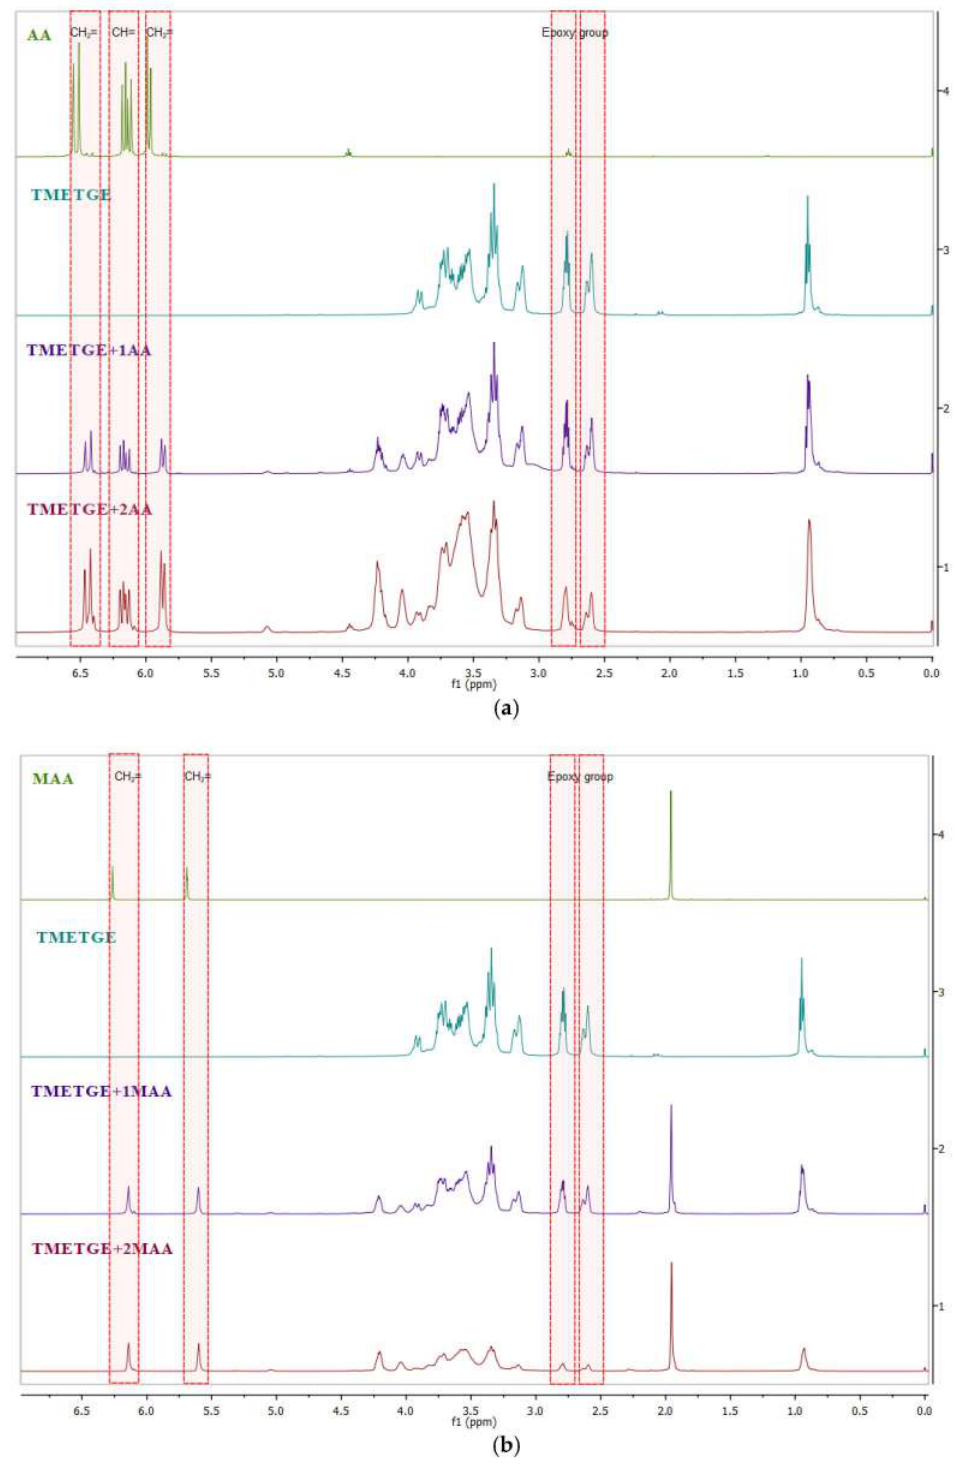
Figure 5. 1 H NMR spectra (CDCl 3 ) of ( a ) AA, triglycidyl ether of trimethylolethane, TMETGE + 1AA, and TMETGE + 2AA (from the top) and ( b ) MAA, triglycidyl ether of trimethylolethane, TMETGE + 1MAA, and TMETGE + 2MAA (from the